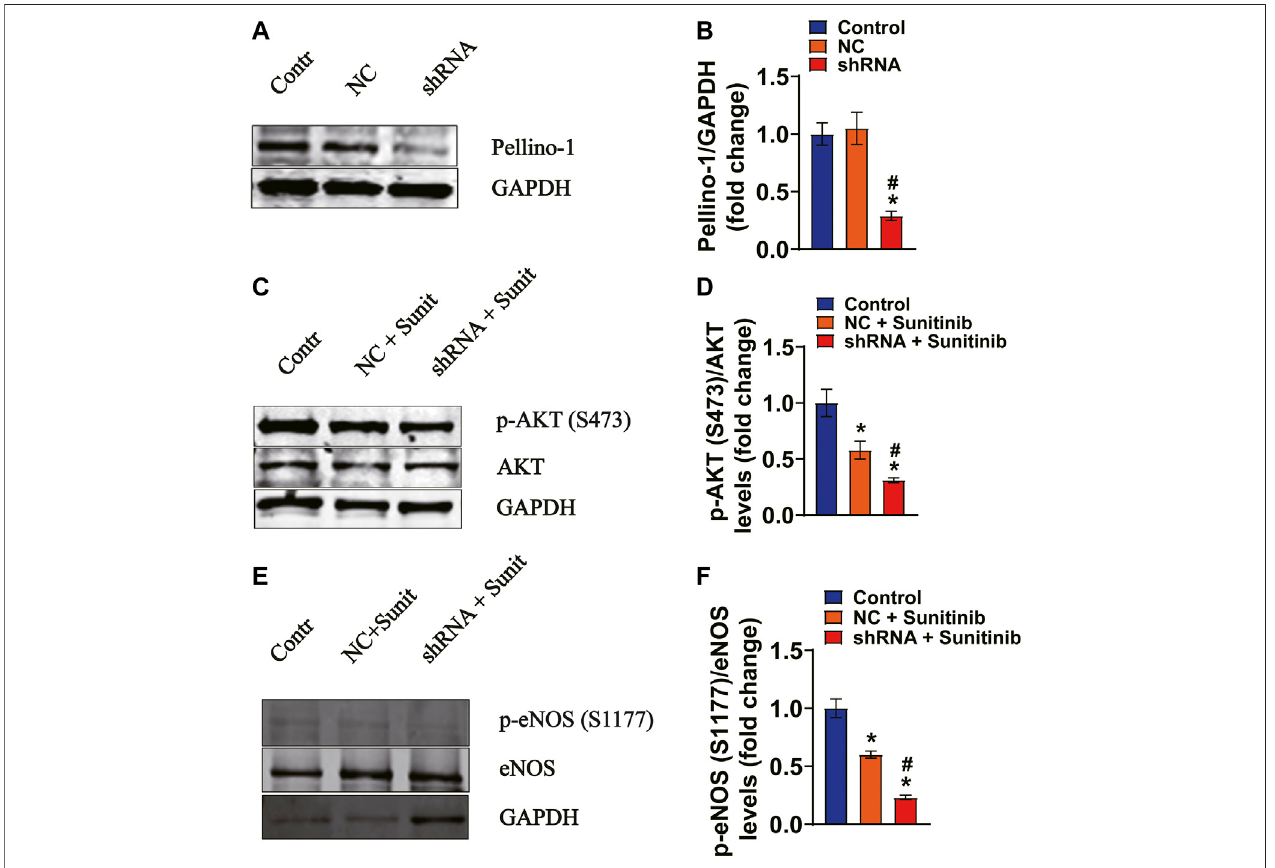
FIGURE7| GenesilencingofPellino-1exacerbatessunitinib-inducedattenuationofAKTandeNOSphosphorylationinMAECs. (A,B) Representativewesternblot images and bar graph demonstrating that knocking down the ef fi ciency of Pellino-1 by the lentivirus-packed rat shRNAs (* p < 0.05 vs. control; # p < 0.05 vs. scramble control; n (cid:2) 6). (C) Representative western blot images demonstrating the expression of total AKT and phospho-AKT Ser 473 protein performed under each indicated conditions. (D) Bar graph representing that sunitinib-induced inhibition of phospho-Ser473 AKT was exacerbated by knocking of Pellino-1 (* p < 0.05 vs. control; # p < 0.05 vs. Sunitinib; n (cid:2) 6). (E) Representative western blot images representing theexpression of total eNOS and phospho-Ser1177 eNOS protein generated under each indicated conditions. (F) Statistic bar graph demonstrating that sunitinib-induced decrease in the expression levels of phospho-Ser1177 was further declined by gene silencing of Pellino-1 (* p < 0.05 vs. control; # p < 0.05 vs. Sunitinib; n (cid:2) 6). NC representing scramble shRNA transfected group; Sunit indicates